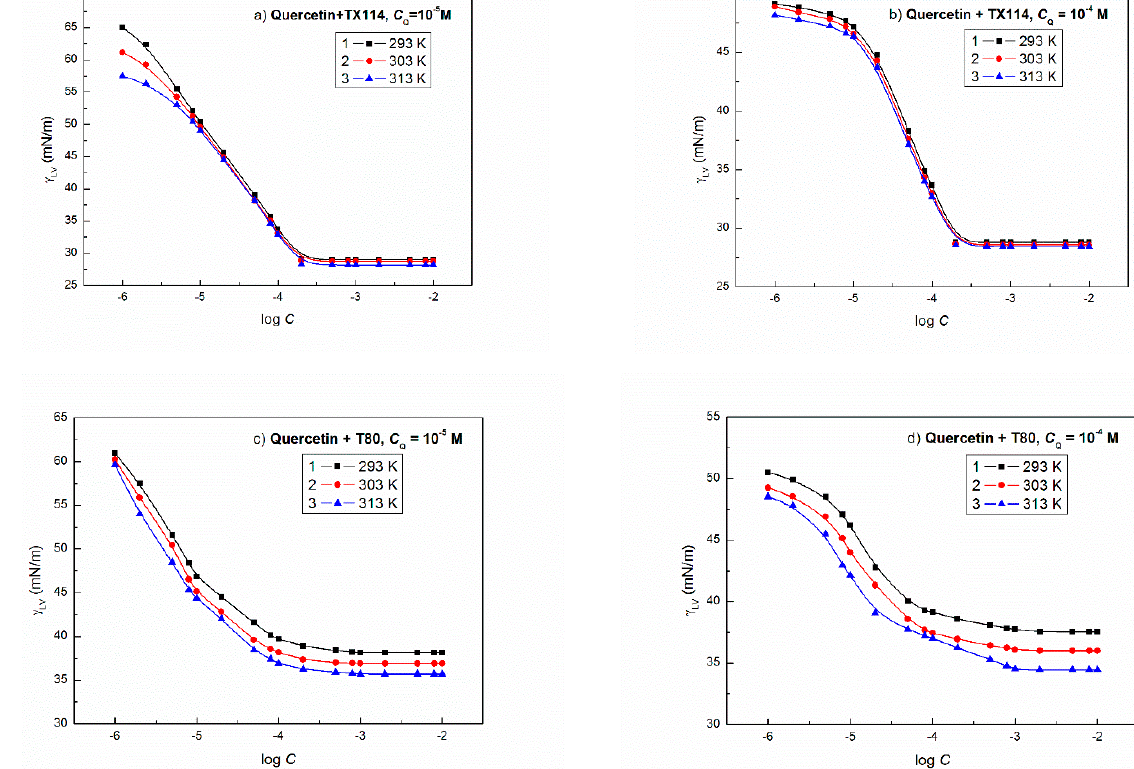
Figure 2. A plot of the surface tension ( γ LV ) of the aqueous solutions of ( a ) Q + TX114 ( C Q = 10 − 5 M), ( b ) Q + TX114 ( C Q = 10 − 4 M), ( c ) Q + T80 ( C Q = 10 − 5 M) and ( d ) Q + T80 ( C Q = 10 − 4 M) vs. the logarithm of surfactant concentration (log C ) at different temperatures equal to 293 (curve 1), 303 (curve 2), and 313 K (curve 3), respectively.